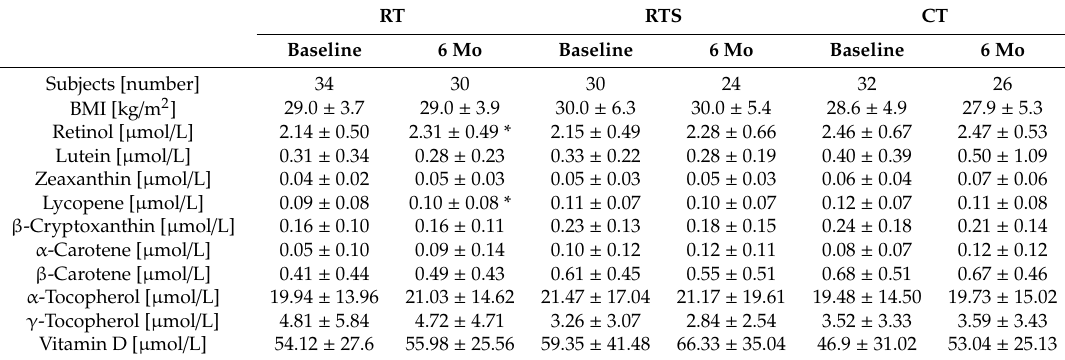
Table 2. The impact of six months (6 Mo) of intervention on the status of fat soluble micronutrients.